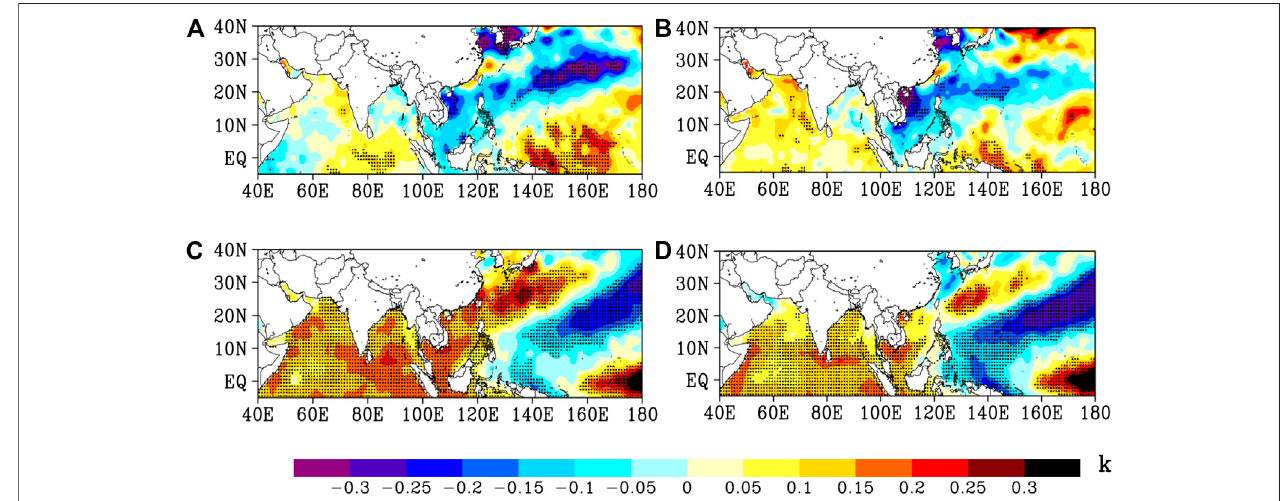
FIGURE12| Regressionmaps ofthe AM-meanSST(shaded; unit: K)against the (left) BOBSMonsettime and (right) SCSSM onsettime for (upper) 1958 – 1979 and (bottom) 1980 – 2018. The stippling denotes values exceeding the 90% con fi dence